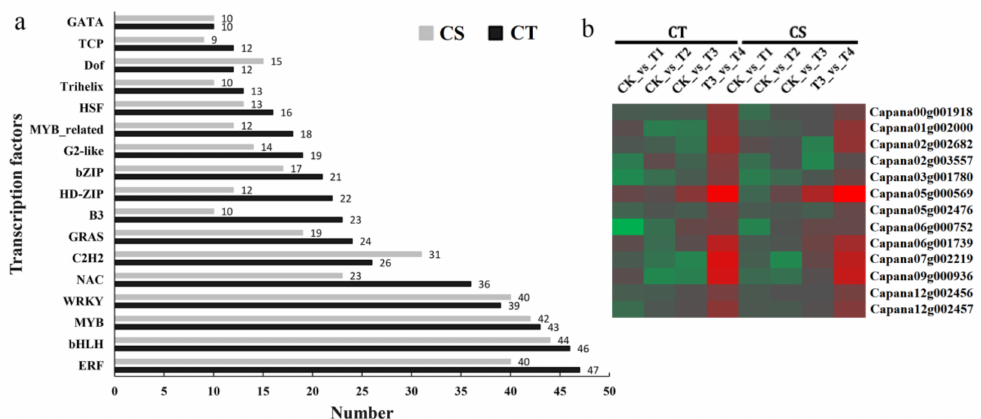
Figure 7. TFs related to cold stress and rewarming in pepper. ( a ) TFs identified in CT and CS. ( b ) Expression patterns of NAC family members. The log2FC values were used for mapping. Red color represents high gene expressions; green color represents low gene